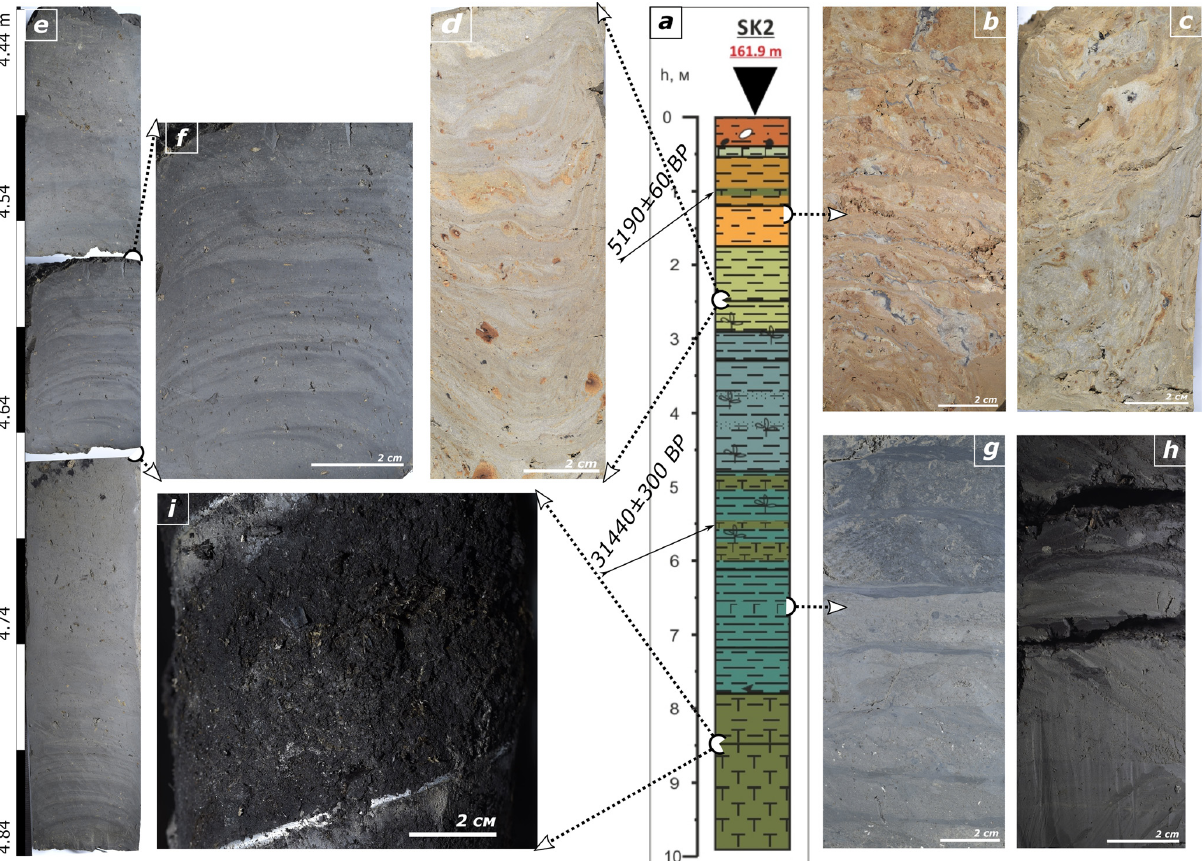
Figure 2. General lithostratigraphy and structure of postglacial sediments of the study site: (a) lithostrtigraphic column of SK2 core; (b) upper sedimentary layer – colluvium with irregular laminae-mottled structure and highly contrast texture; (c) fragment of cryogenic structure with subvertical laminae in colluvium; (d) regularcm-scale lamination in the upper lacustrine unit; slight cryogenic deformations, carbonate sand grains and ferrugineous nodules infilling fragments of plant detritus; (e) dm-scale stratification and (f) cm- and mm-scale laminae in the intermediate lacustrine unit; (g) cm-scale lamination with subangular clayey clasts and (h) fragments of dense peaty laminae in the lower lacustrine unit; (i) laminated basal